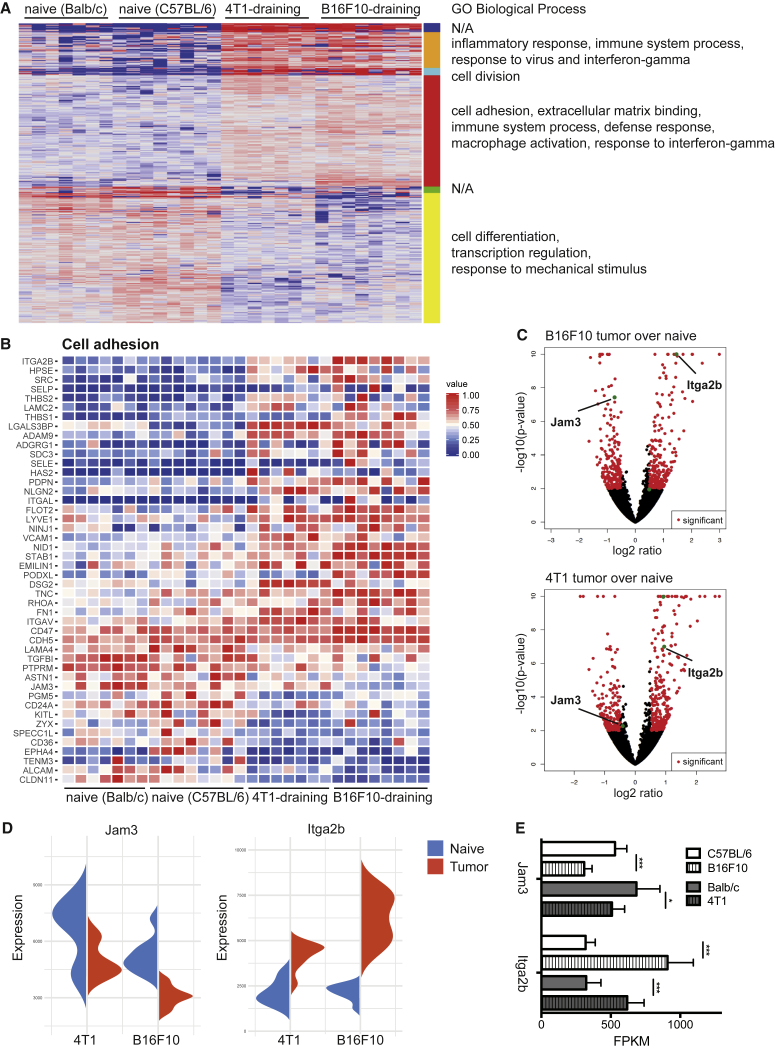
The Expression Pattern of Cell Adhesion Molecules Is Dramatically Changed in LECs from Tumor-Draining LNs(A) Heatmap of differentially expressed genes in tumor-draining compared to naive LN LECs. GO clusters of biological processes are indicated on the right.(B) Heatmap of differentially expressed cell adhesion genes (GO: 0007155) in both tumor models.(C–E) Differentially expressed genes displayed in (C) volcano plots, (D) violin plots, and (E) normalized read counts (fragments per kilobase of transcript per million mapped reads [RPKM]) in both tumor models compared to the respective naive controls.Data are shown as mean with SD and differences were considered statistically significant when p < 0.05, as indicated by ∗p < 0.05, and ∗∗∗p < 0.001. See also Figure S4 and Table S2.